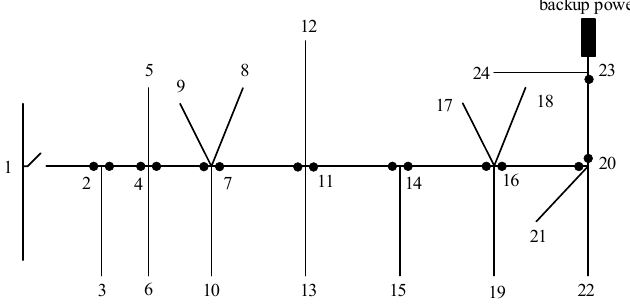
Figure 12. Example 2: alternative switch-position map (with contact).